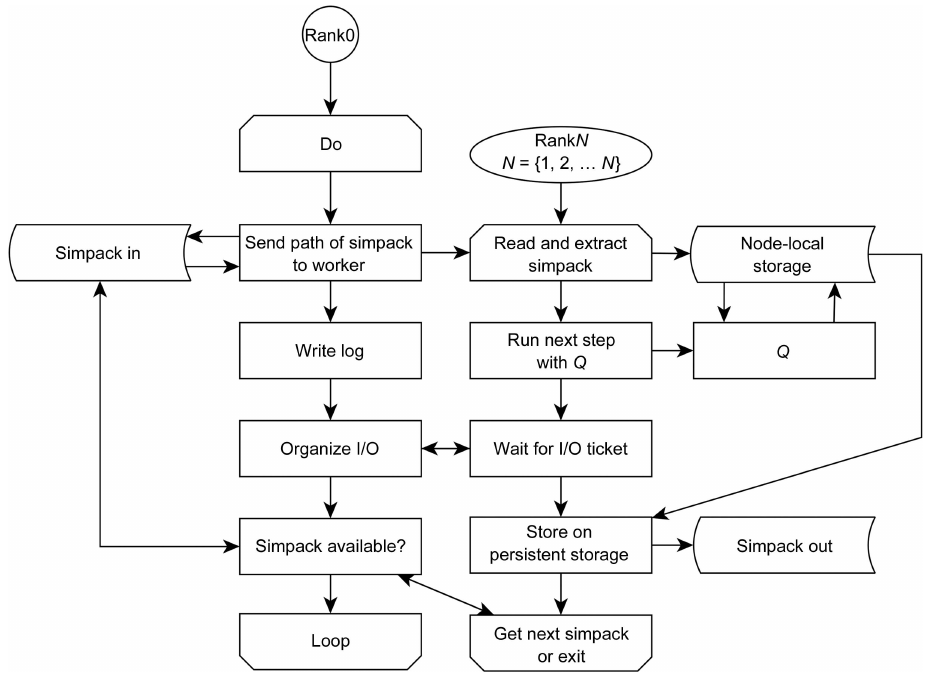
Figure 5 CADEE ensemble-simulation flowchart. When CADEE is initialized, it first locates all simpacks available in the initialization directory. It then distributes them on the available resources and runs each step of a simpack using Q . After completion of the simpack, the next simpack is executed. Individual simpacks are independent of each other and are executed in parallel, provided that multiple cores are available on the